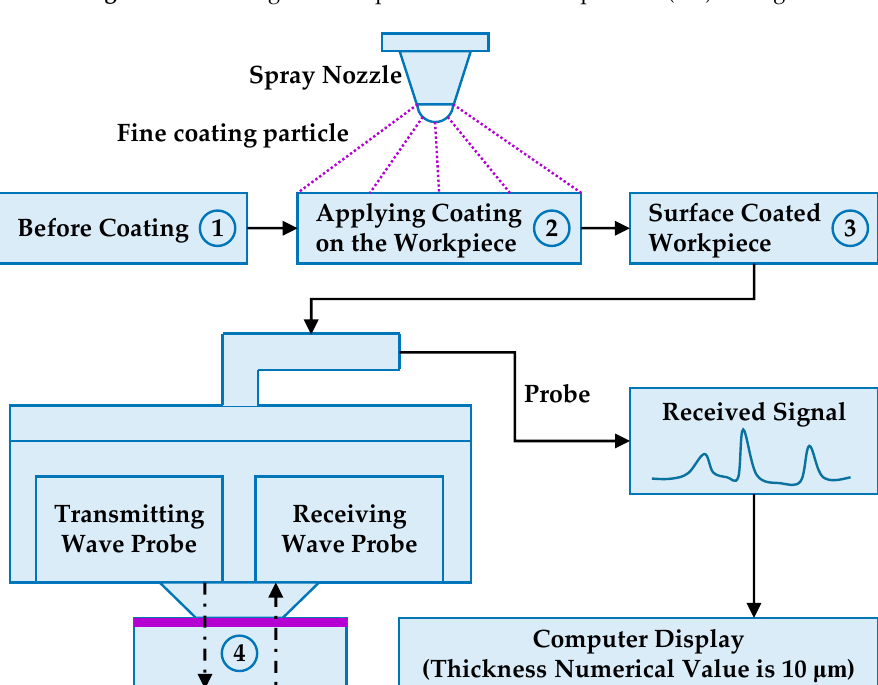
Figure 4. Coating thickness measurement by the ultrasonic probe sensors.